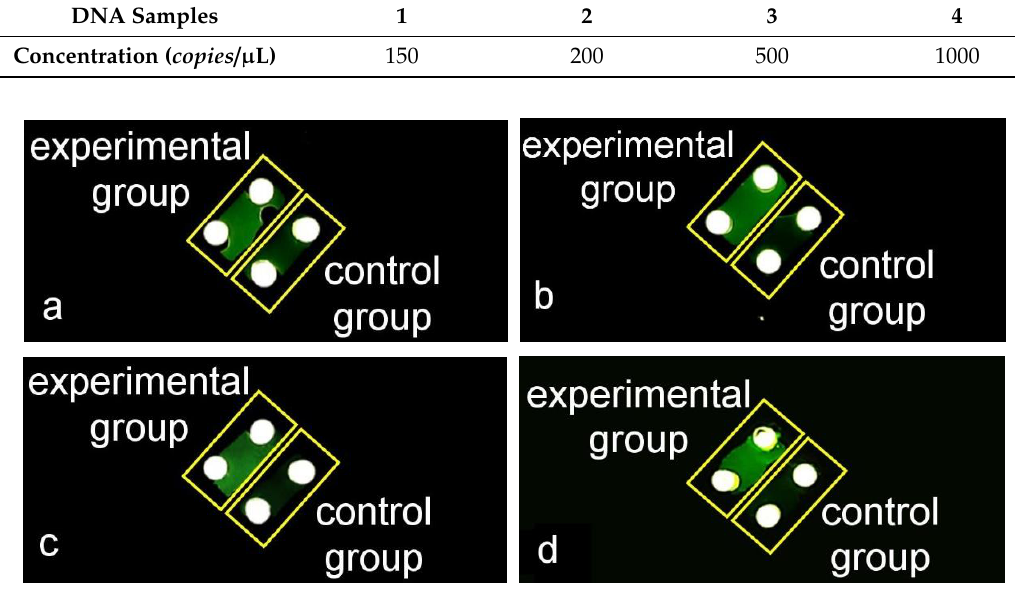
Figure 12. The results of amplifying HPV16E6 genomic DNA samples in different initial concentrations. The top-left chambers were the experimental groups and the bottom-right chambers were the control groups. ( a ) The results of amplifying DNA sample 1. ( b ) The results of amplifying DNA sample 2. ( c ) The results of amplifying DNA sample 3. ( d ) The results of amplifying DNA sample 4.